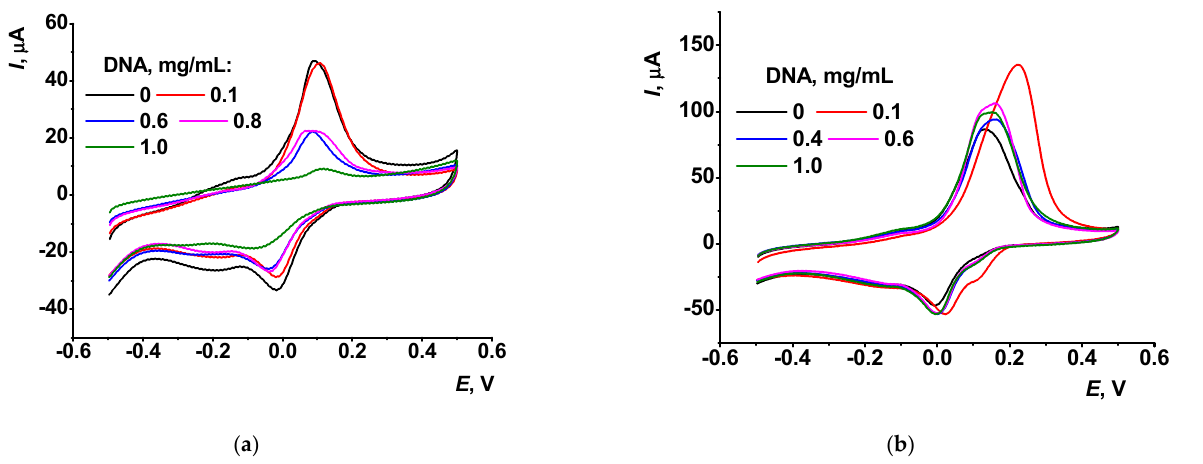
Figure 7 . Cyclic voltammograms recorded on GCE covered with CB and the mixture of 50 μ M TC and 0 (1), 0.1 (2), 0.6 (3) and 1.0 (4) mg/mL DNA at first ( a ) and 10th ( b ) cycle. Measurements in 5.0 mM methylene green solution, 0.1 M HEPES, 100 mV/s. Numbers correspond to the number of cycling performed in the same solution.